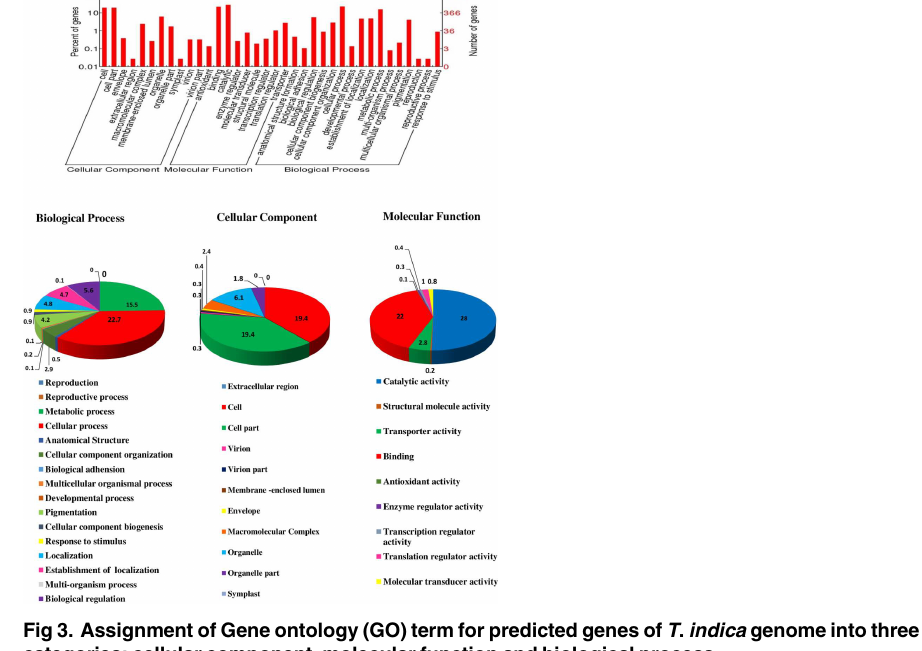
Similarly, three main protein kinases mediated signaling pathways (MAPK, cAMP and Ca) govern pathogenicity and infection–related development of the pathogenic fungi. The main groups of fungal protein kinases are STE, CMGC, AGC and CAMK. STE and CMGC kinases have a role in MAPK pathway, AGC is invoved in both cAMP and Ca signaling pathway and CAMK in only Ca signaling pathway [33]. The T . indica genome contains 125 protein kinases which is fewer than other hemibiotrophic fungi, 147 in Curvularia lunata and 140 in Bipolaris